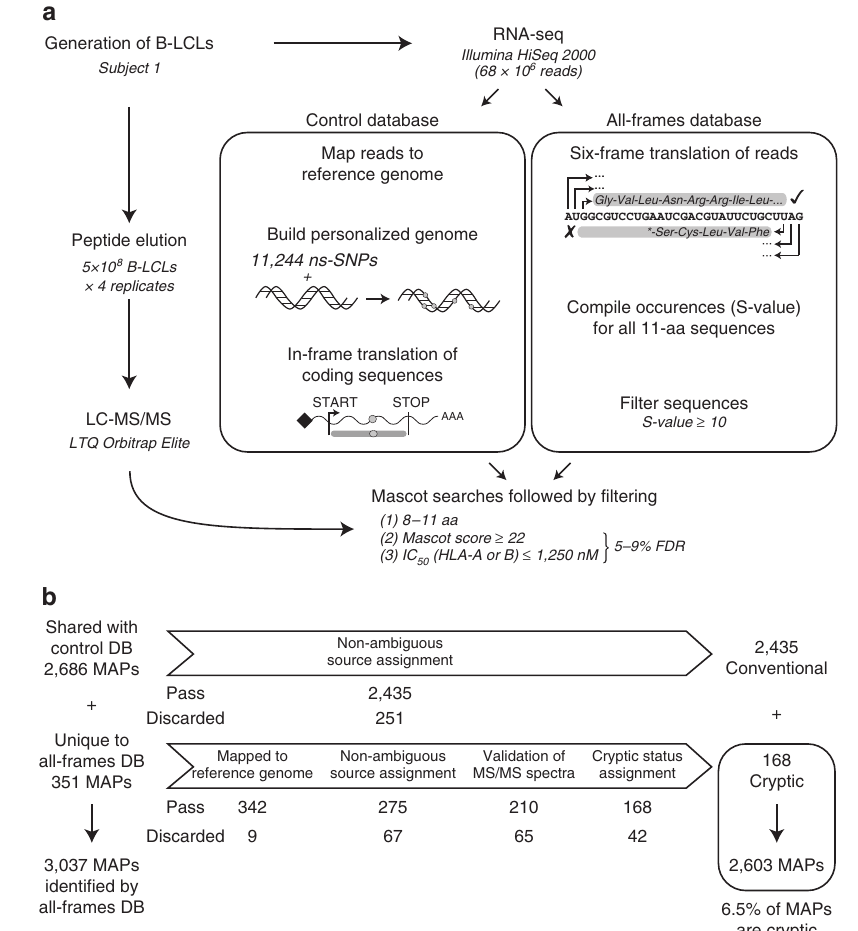
Figure 1 | Proteogenomic workflow used for high-throughput identification of cryptic MAPs. ( a ) General overview of the proteogenomic workflow used to identify conventional (Conv.) and cryptic (Crypt.) MAPs. Peptides were eluted from the cell surface of subject 1’s B-LCL and were sequenced with liquid chromatography-MS/MS (LC-MS/MS). To determine the amino-acid (aa) sequence of those peptides, we built two databases (DBs), both derived from the analysis of RNA-seq data obtained from subject 1’s B-LCL: the control DB and the all-frames DB (see Methods and Supplementary Fig. 1). ( b ) Peptides solely identified by the all-frames DB were considered as Crypt. MAP candidates and further filtered to remove ambiguous and false-positive identifications. See also Supplementary Figs 2 and